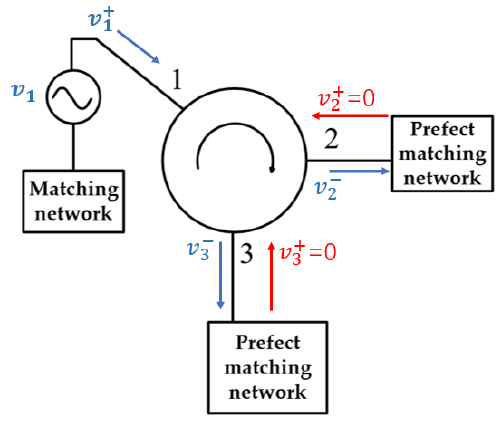
Figure 10. Method of calculating S-parameters.